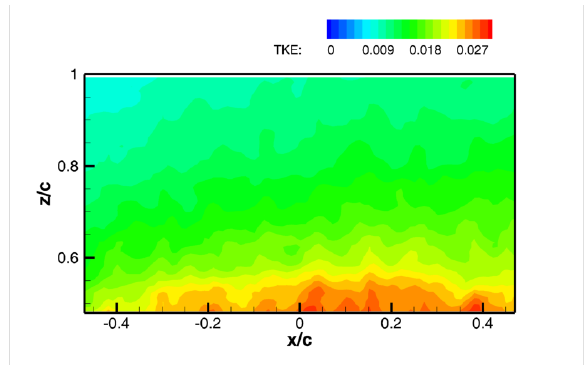
Fig. 9. TKE distribution, measuring plane 2 .